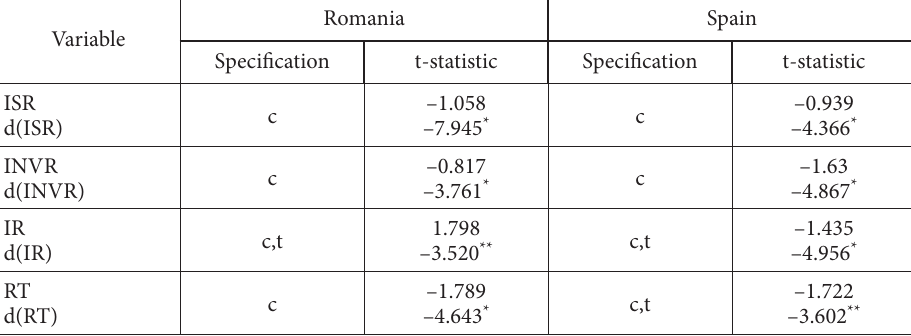
Table 1. Tests of stationarity (Augmented Dickey-Fuller test)